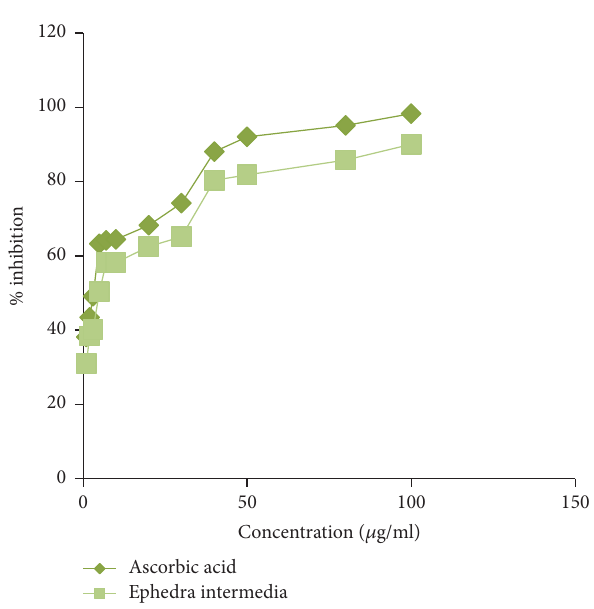
Figure 3: % inhibition of ascorbic acid standard and Ephedra inter- media